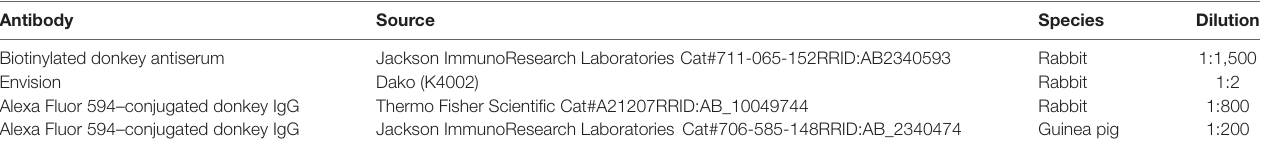
TABLE 2 | Secondary antibodies.